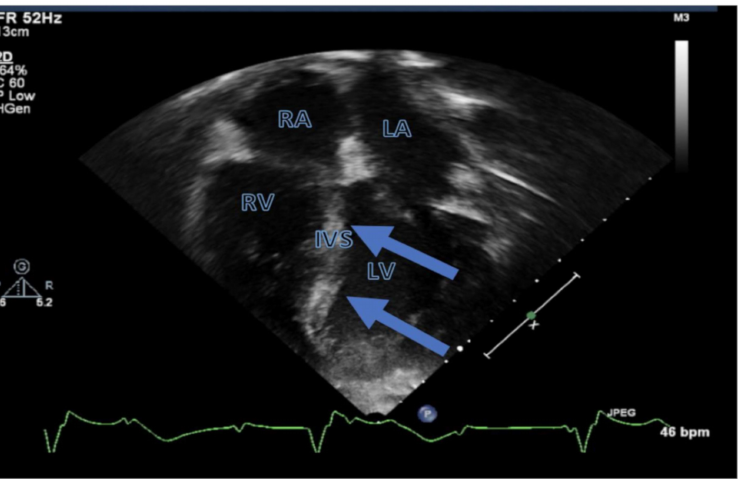
Figure 1. Echocardiogram of the patient on the day of presentation. The arrows point to echo-bright areas over the interventricular septum indicating leukemia cell infiltration. RA, right atrium; RV, right ventricle; LA, left atrium; LV, left ventricle; IVS, intraventricular